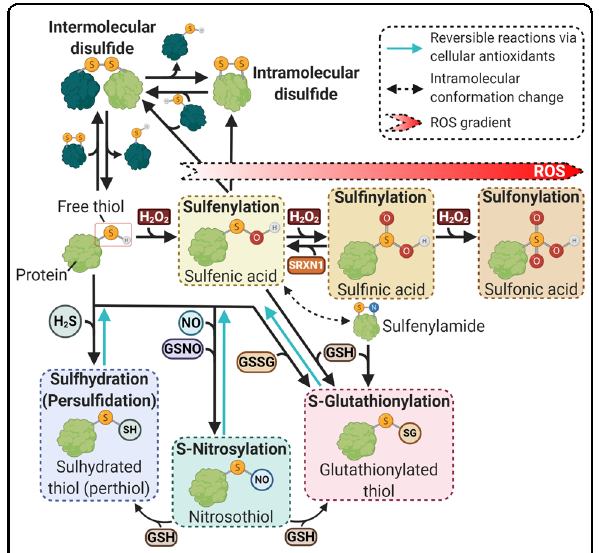
Fig. 2 Different types of oxidative post-translational modi fi cations (oxPTMs) to the thiol group on cysteine amino acid in proteins. In the presence of cellular hydrogen peroxide (H 2 O 2 ), the free thiol will undergo sulfenylation to form sulfenic acid, which in recent times has been considered an important intermediate in redox signaling. In the presence of increasing oxidative stress, the elevated levels of cellular H 2 O 2 would lead to the sulfenic acid undergoing sul fi nylation to form irreversible sul fi nic acid. However, the presence of SRXN1 could convert the sul fi nic acid back to sulfenic acid. With even higher concentrations of cellular H 2 O 2 , sul fi nic acid can undergo further reaction via sulfonylation to form sulfonic acid, which is the fi nal irreversible form of thiol. This highlights the detrimental effects of increasing oxidative stress in cells, which could lead to formation of the irreversible sulfonic acid and the loss of function of important proteins in the cell. Another important thiol oxPTM is the formation of disul fi de bonds, both intermolecularly and intramolecularly. The formation of the disul fi de bonds is known to potentially activate as well as inhibit the function of the target proteins. Another notable oxPTM is the S-glutathionylation of proteins in the presence of glutathione molecules. Other modi fi cations of free thiol include the sulfhydration by H 2 S, which is an important modi fi cation in the central nervous system, and S-nitrosylation that is induced by reaction nitrogen species in the cell. Created with